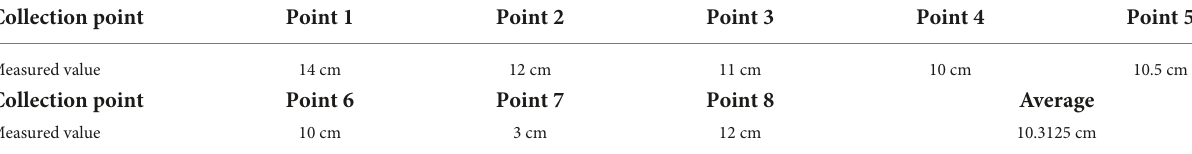
TABLE 5 Navigation accuracy test value of each sampling point (Group 2).